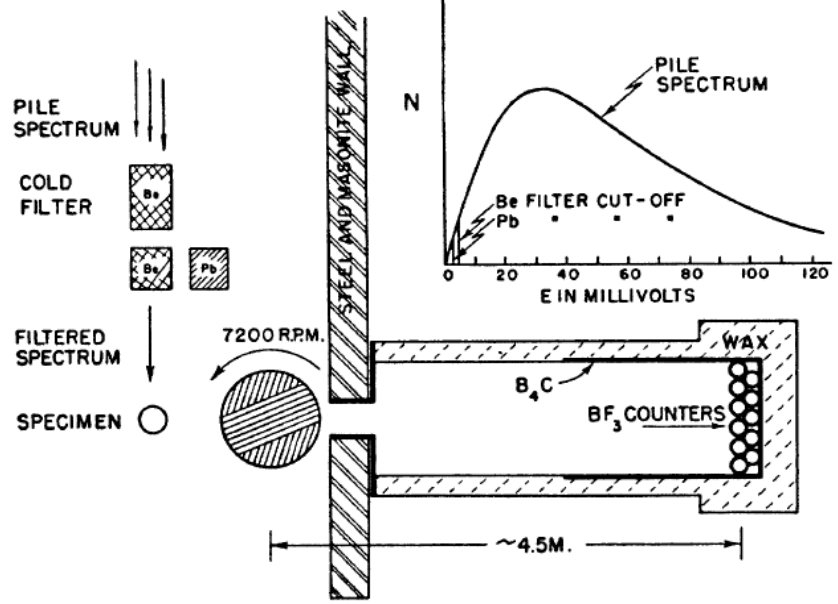
Figure 6. Schematic drawing of the filter-chopper spectrometer at Chalk River. The incident neutron beam passes alternatively through cold Be or cold Be and Pb filters. The scattering angle, Φ , at the sample is 90 ◦ and the scattered energy is determined in time of flight over a path of 4.5 m with a Fermi chopper rotating at 7200 rpm. The neutrons are counted in well-shielded BF 3 counters. The inset shows the Maxwellian spectrum and the position of the Pb and Be filter Bragg cut-offs. This figure is taken from Figure 3 of ref. [19]. Copyright by the American Physical